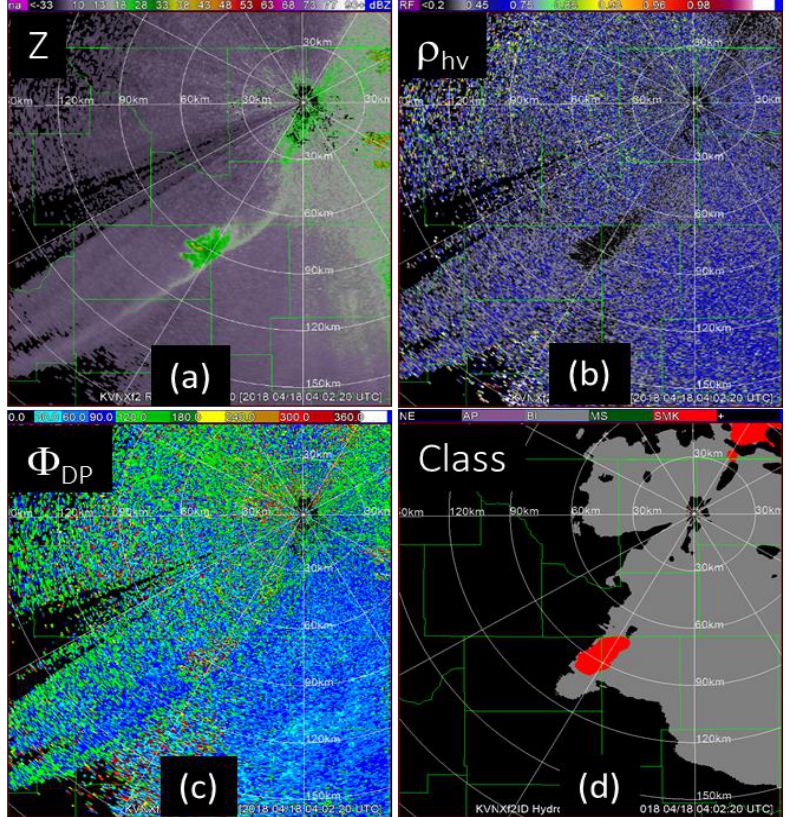
Figure 19. Fields of Z, ρ hv , Φ DP , and ( d ) the results of a rudimentary classification (red color). Data is from the April 18, 2019 wildfire case in Oklahoma (time 04:02 UTC). Classes are clutter from anomalous propagation (AP), biological scatterers (BI), meteorological returns (MS), and smoke plumes (SMK). ( a ) reflectivity, ( b ) correlation coe ffi cient, ( c ) di ff erential phase, and ( d ) results of